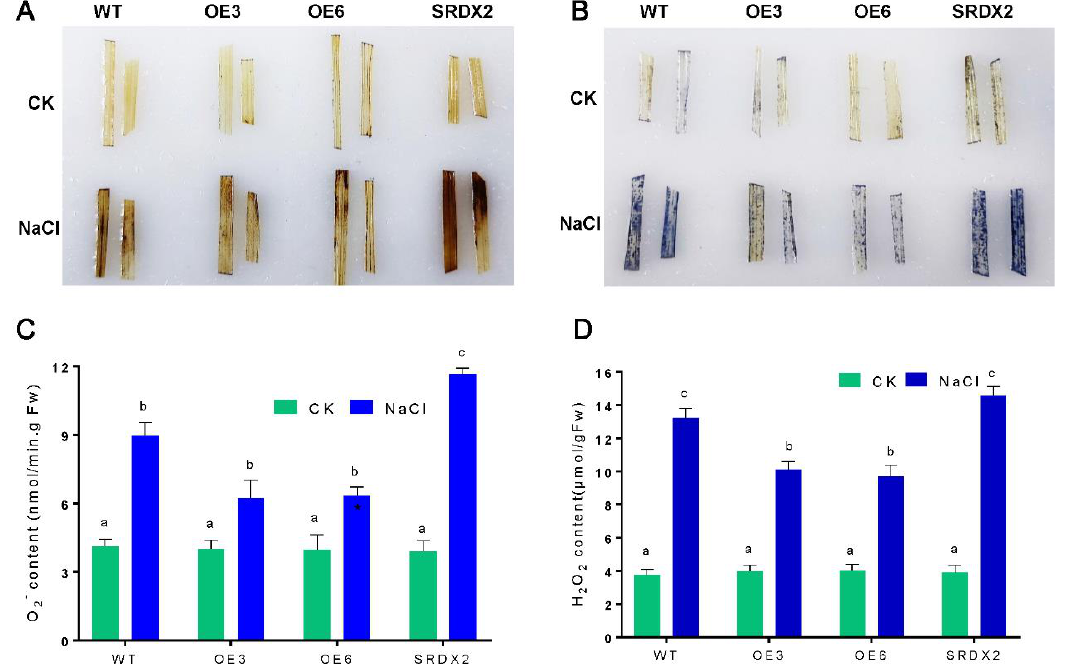
Figure 6. OsNACL35 modulates ROS content under salt stress. ( A ) DAB staining. ( B ) NBT staining. Three independent experiments were conducted (n ≥ 15), showing similar results. ( C ) O 2 − content. ( D ) H 2 O 2 content. The 21-day-old rice seedlings grown under control and salt-stress (350 mM NaCl) conditions for 4 days. Statistical analyses were performed by a two-way ANOVA, followed by a Tukey’s multiple comparison test. Different letters indicate significant differences at p < 0.05.